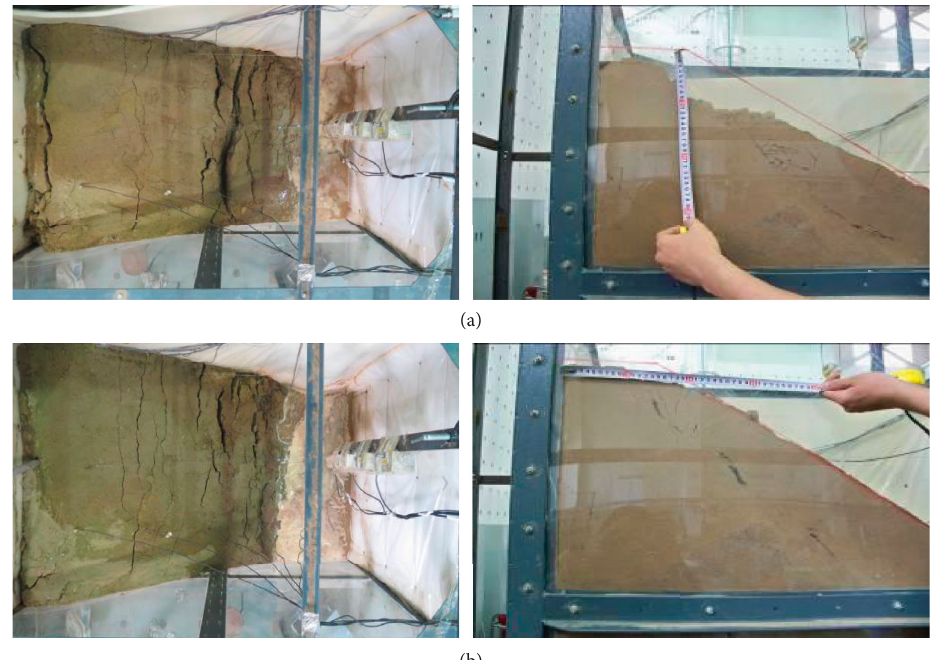
Figure 23: Plastic failure of the slope before and after strengthening. (a) Plastic failure of the slope before strengthening. (b) Plastic failure of the slope after